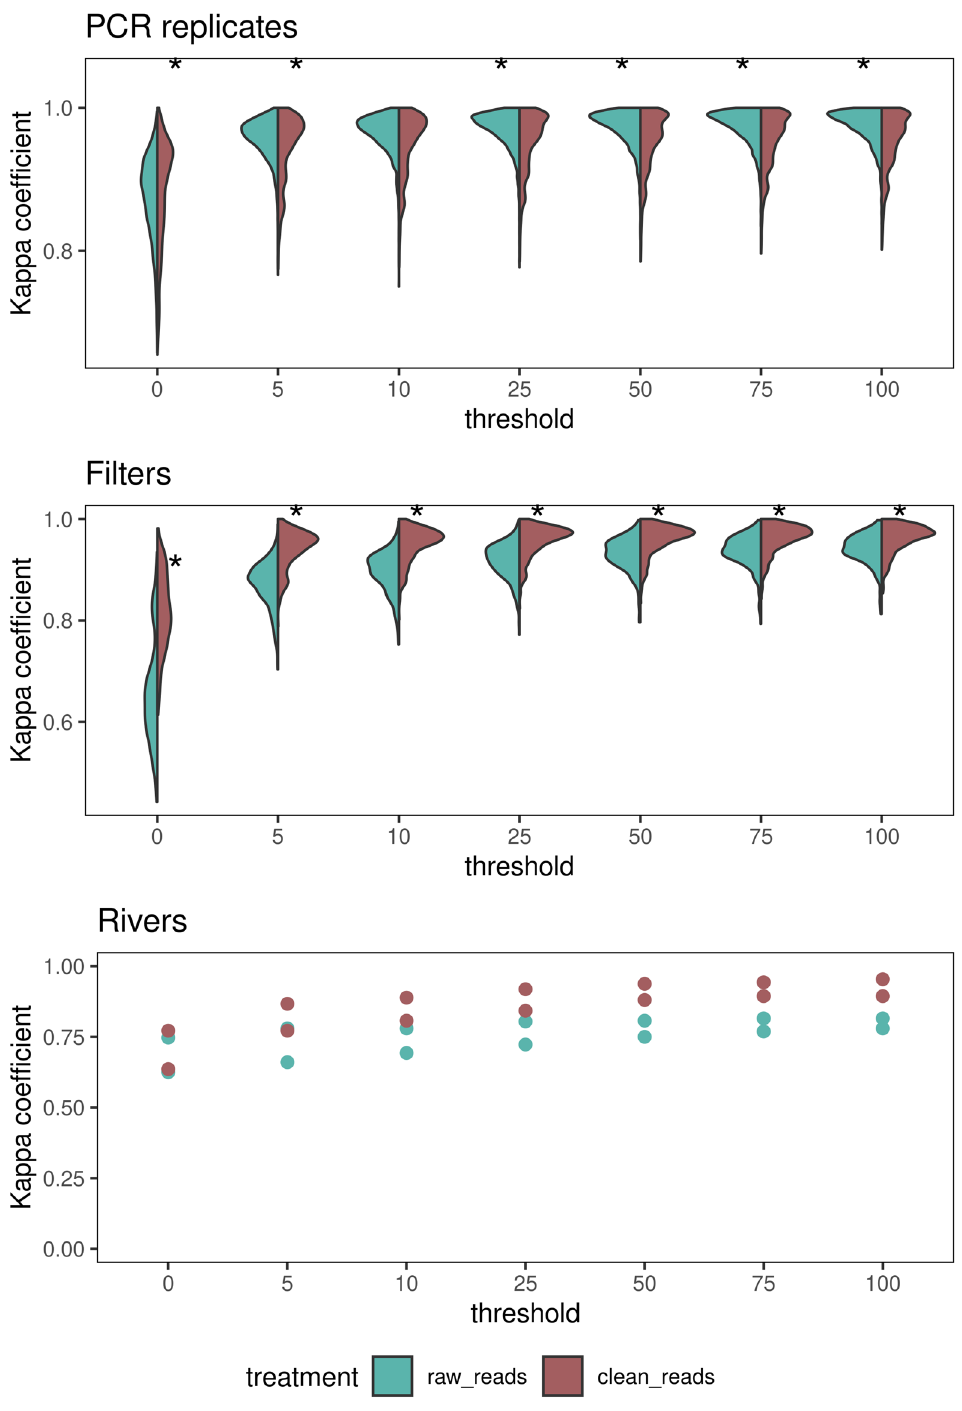
Figure 3. Kappa correlation coefficient between the outputs of the CNN and OBITools. The left side of the violin plots (blue) displays correlation values between OBITools and the CNN applied to raw reads. The right side of the violin plots (red) displays correlation values between OBITools and the CNN applied to clean reads. The x-axis represents the threshold of the minimum read number per species for the species to be considered present. Stars represent a significant difference between the two